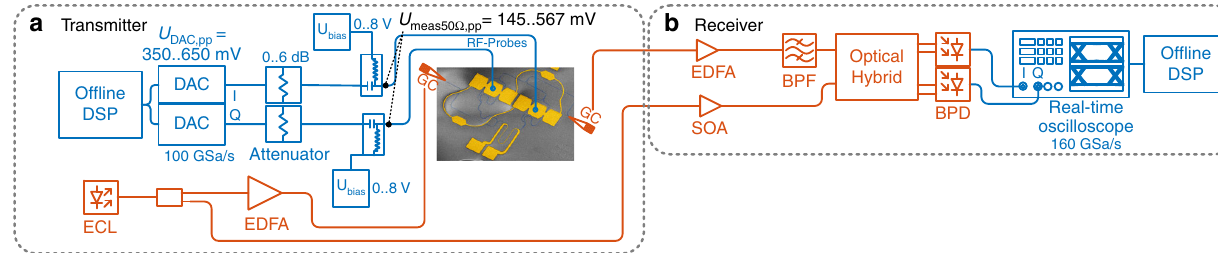
Fig. 6 Experimental setup for low-drive voltage data generation experiment without driving ampli fi er